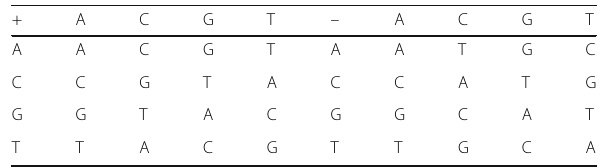
Table 1 DNA encoding